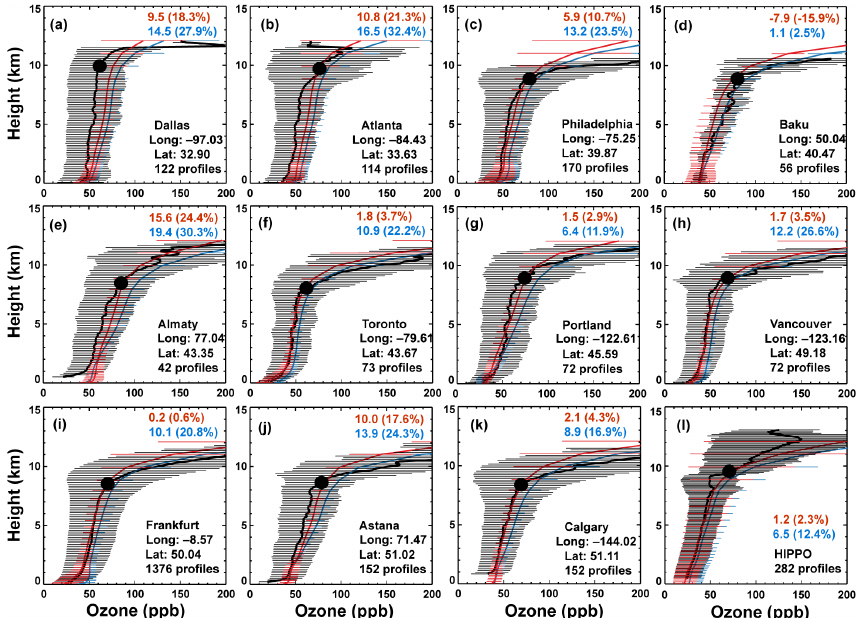
Figure 7. Measured (black) and simulated (red for two-way coupled model and blue for global model alone) vertical profiles of ozone in 2009 for the MOZAIC (a–k) and HIPPO campaigns (l) . MOZAIC measurements are from the ground level (0.075km) to the UTLS at 0.15km intervals, as averaged over all profiles. HIPPO data are averaged over all profiles at 0.1km intervals. Model results are sampled at times and locations coincident to the measurements, except that the model vertical layers are kept for clarity. Horizontal lines indicate 1 standard deviation. Also shown in each panel are the city name, longitude, latitude, number of profiles and mean model biases below 9km (the mean tropopause height). The black dot in each panel depicts the average tropopause height calculated from the two-way coupled